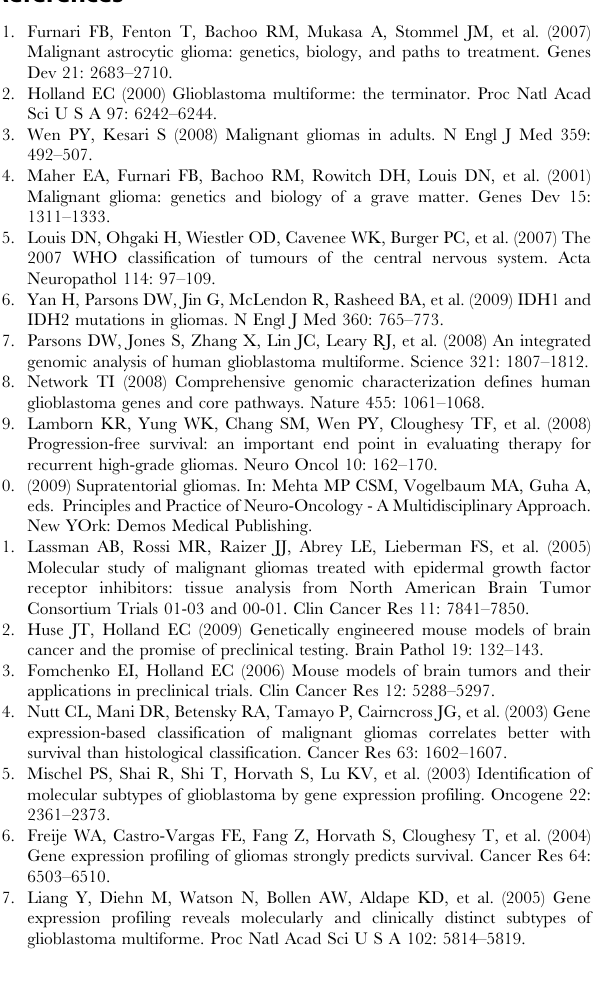
Table S1 Antibodies and conditions used for western blot panel. Antibody sources and conditions as shown. *Hes1 antibody kindly provided by Dr. Tetsuo Sudo (Toray Scientific, Japan).